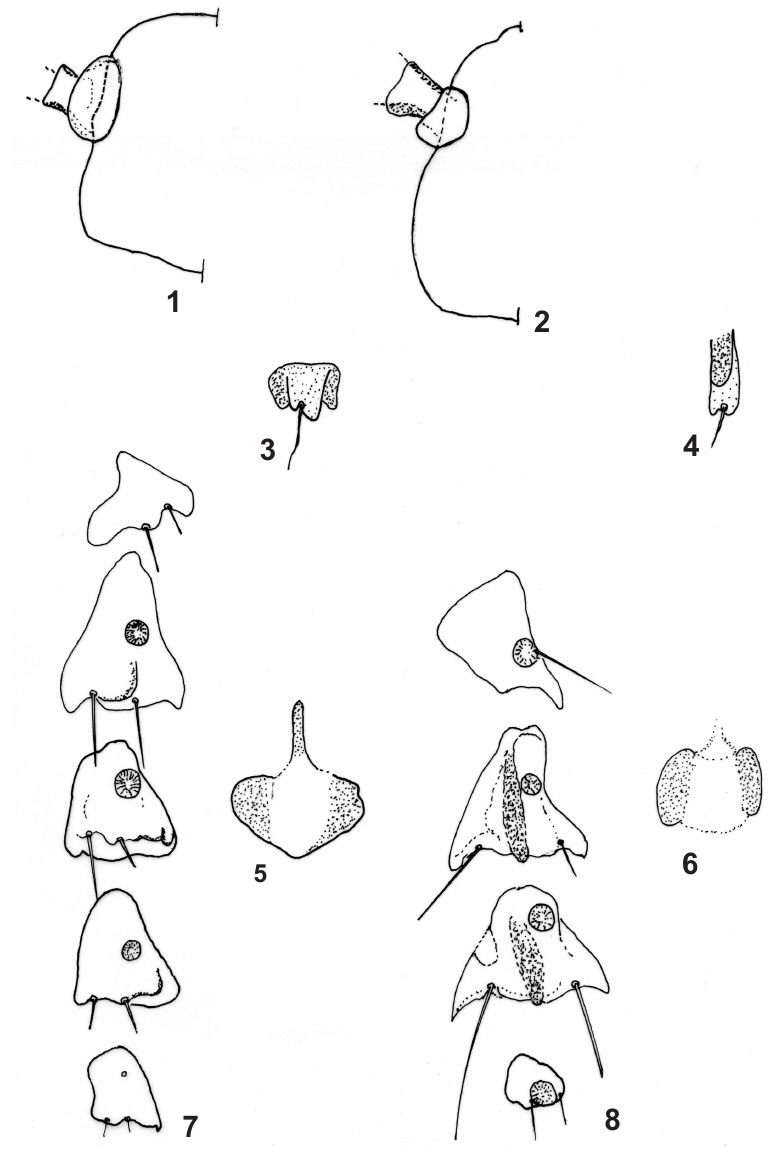
Fig. 1. – Espèces du genre Enderleinellus en France (les chiffres impairs concernent E. nitzschi , les chiffres pairs, E. tamiasis ). 1-2 : capsules cépha- liques en vue dorsale (semi-schématiques); 3- 4 : plaques du sternite II; 5-6 : plaques sternales; 7-8 : plaques paratergales (dessins